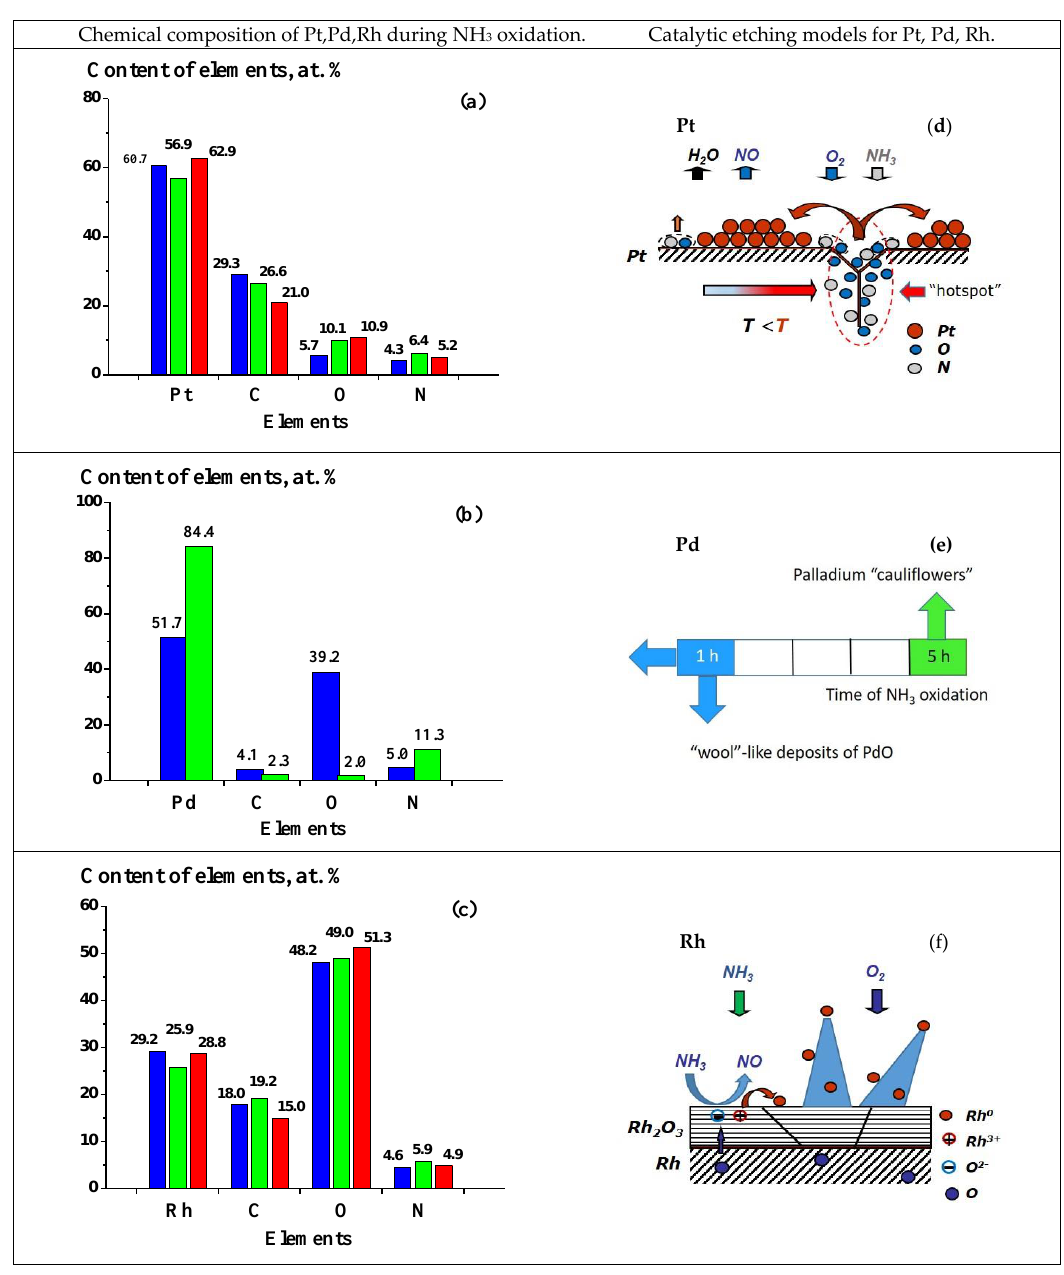
Figure 10. Concentrations of metals (Pt, Pd, Rh) and C, O, N according to EDS data on Pt(poly) ( a ), Pd(poly) ( b ) and Rh(poly) ( c ) after NH 3 oxidation at 1133 K for 1 (left blue columns), 5 (central green columns) and 10 (right red columns) h. Models of NH 3 oxidation and catalytic etching initiated by this reaction for Pt ( d ), Pd ( e ) and Rh ( f ).